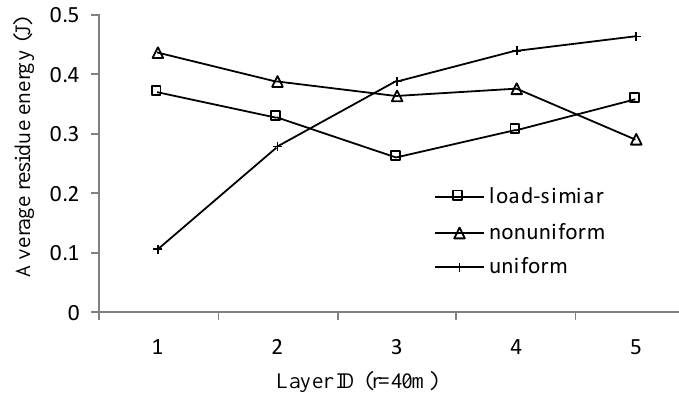
Figure 11. Average residue energy vs. layer ID ( r = 40 m